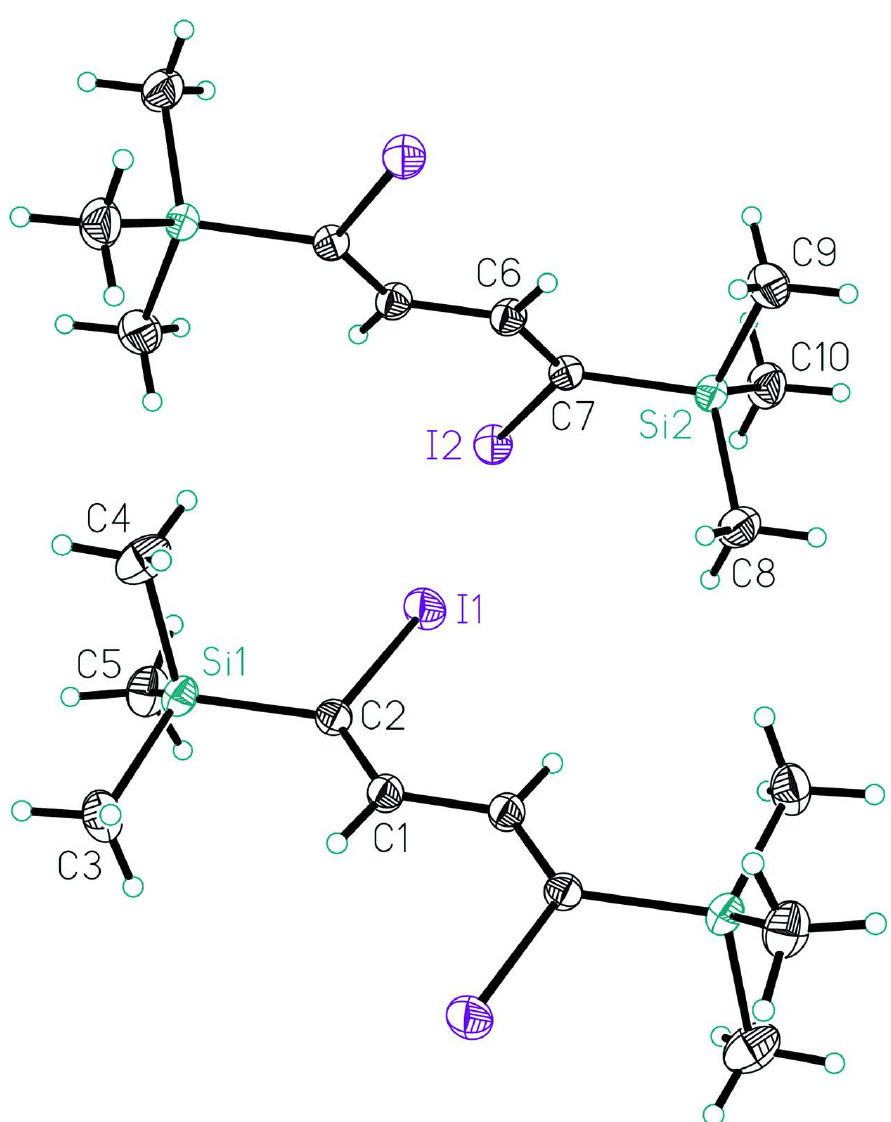
A view of the two independent molecules of the title compound, with displacement ellipsoids drawn at the 50% probability level (Unlabeled atoms are related to labeled atoms by inversion centers at the midpoints of the